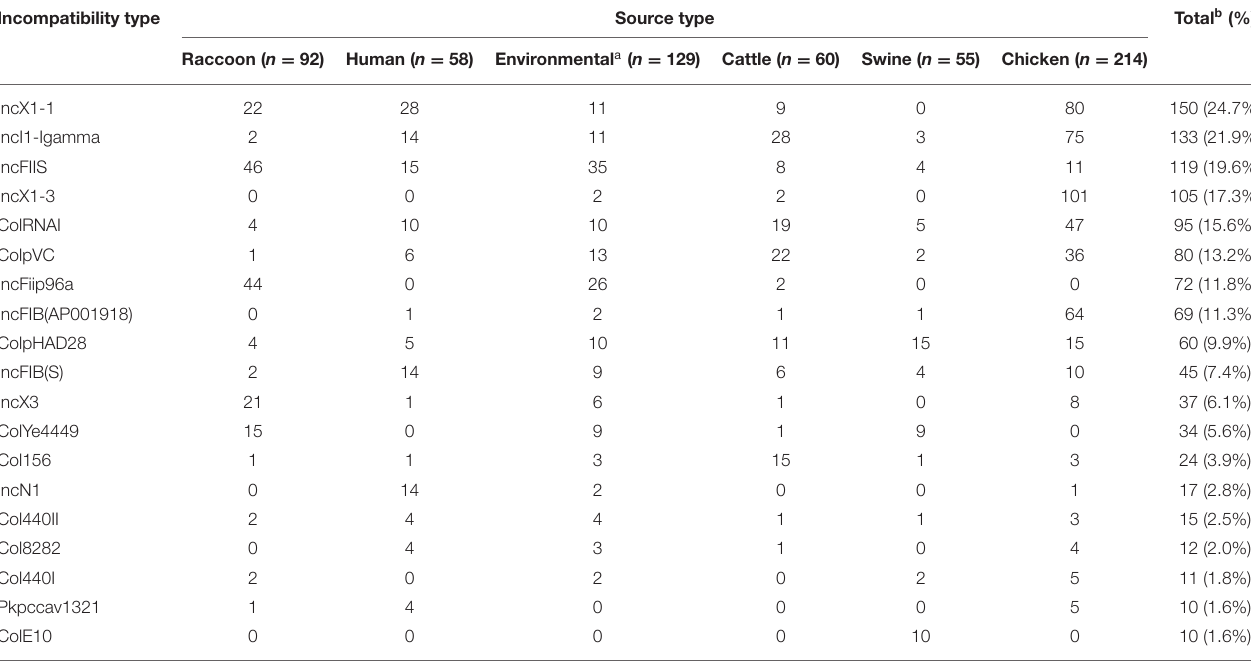
TABLE 4 | Distribution of predicted plasmids identified using whole-genome sequence data by source type for Salmonella enterica isolates from raccoons, humans, livestock, and environmental sources in southern Ontario, Canada 2011 – 2013 ( n =